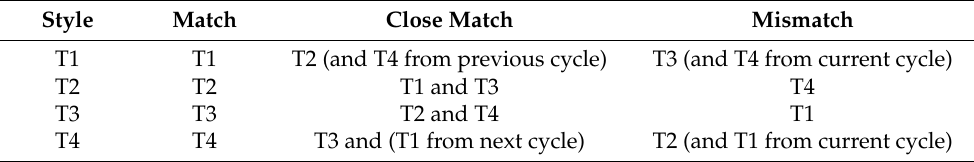
Table 2. Interactions and relationships between teaching styles, after Grow (1991) [8].